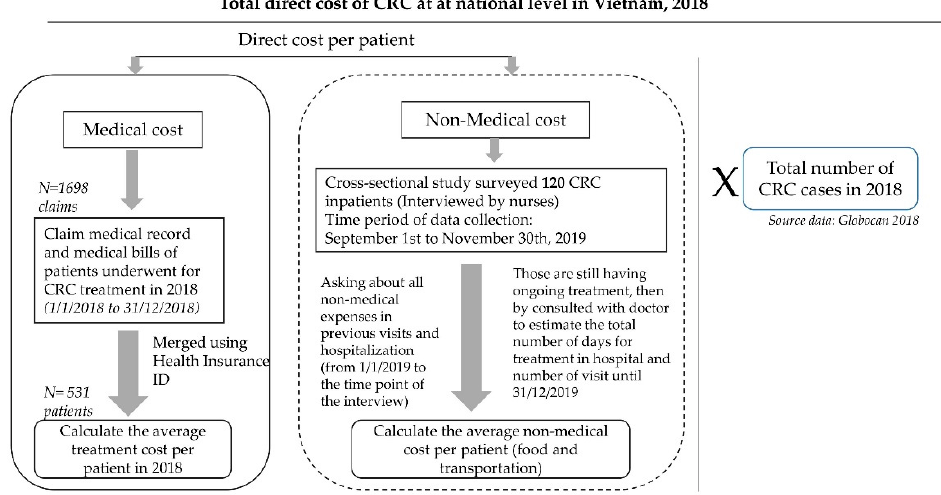
Figure 1. Study diagram of estimation for the direct cost of colorectal cancer in Vietnam, 2018.